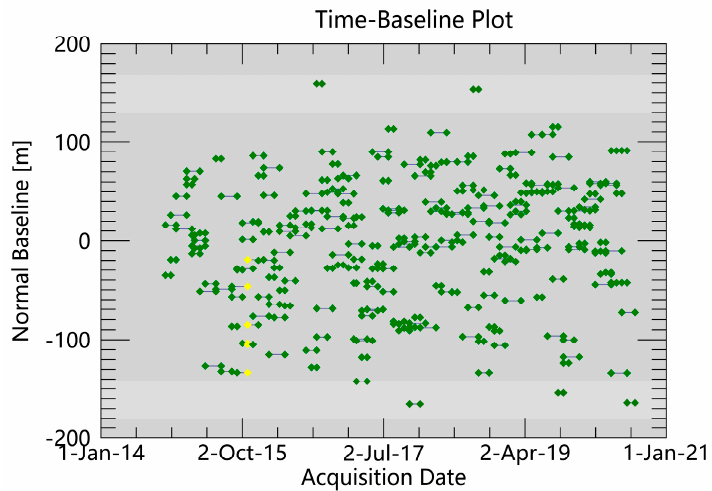
Figure 5. Time-Baseline map of Sentinel-1A ascending data.